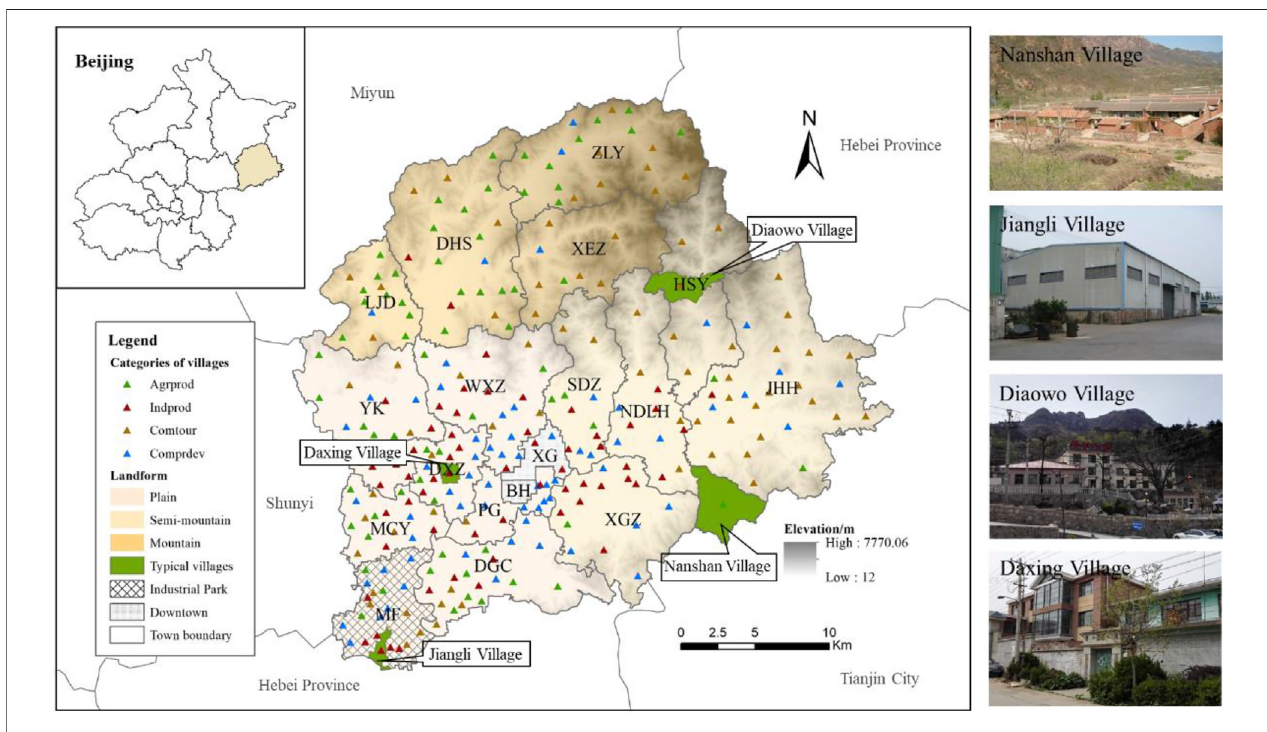
FIGURE 2 | Study area — Pinggu District in Beijing.